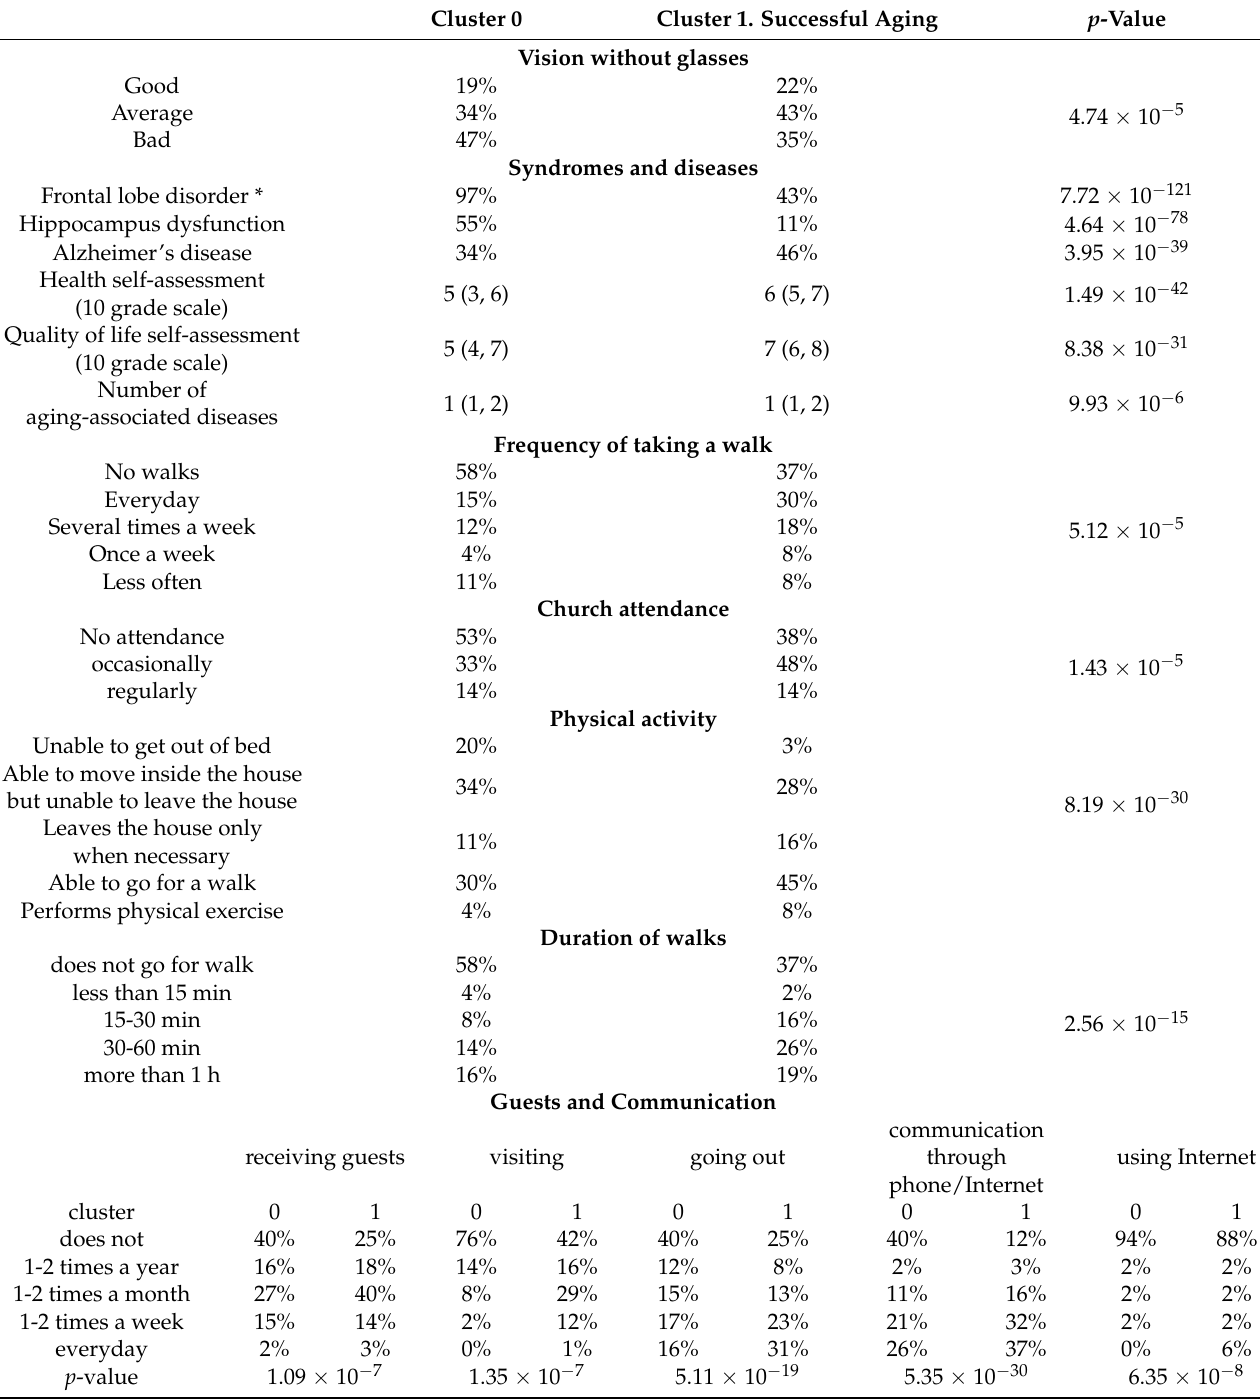
Table 4. Cont . Cluster 0 Cluster 1. Successful Aging p